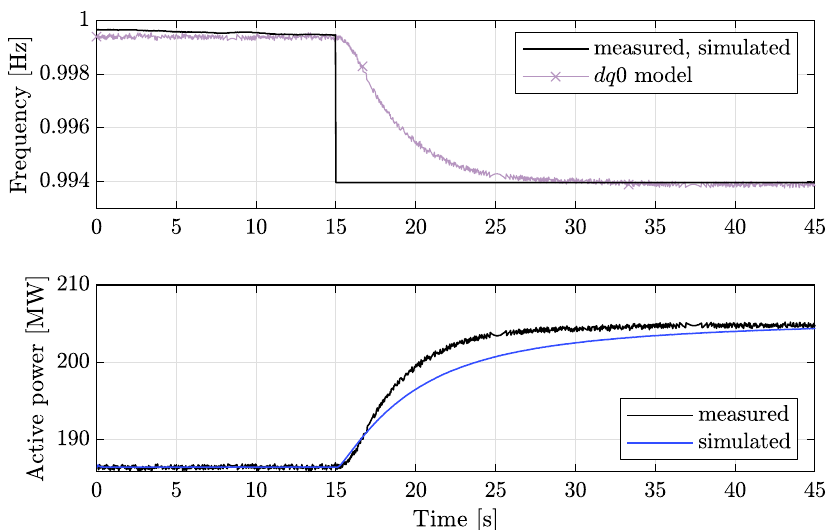
Figure 14. Frequency Control Experiment 1: under-frequency response test. Comparison of simulations and experimental results. The frequency signal is changed from 60 Hz to 59.62 Hz.